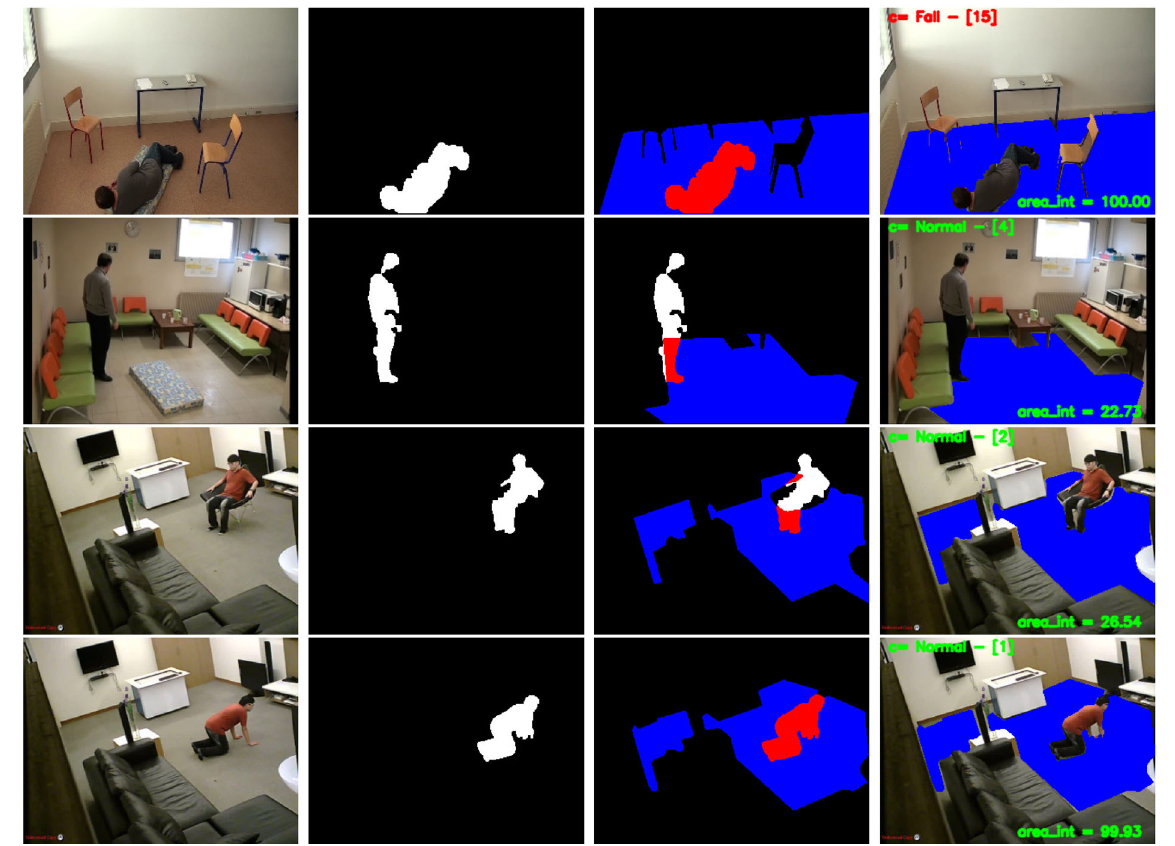
Fig. 16 Different activities. Row 1: falling to the floor. Row 2: standing on the floor. Row 3: sitting on a chair. Row 4: Bending. Left to right: input frame, detected human silhouette, floor (blue) and its intersection with the human body (red, white is the part of the body not intersecting with the floor), output of our system.